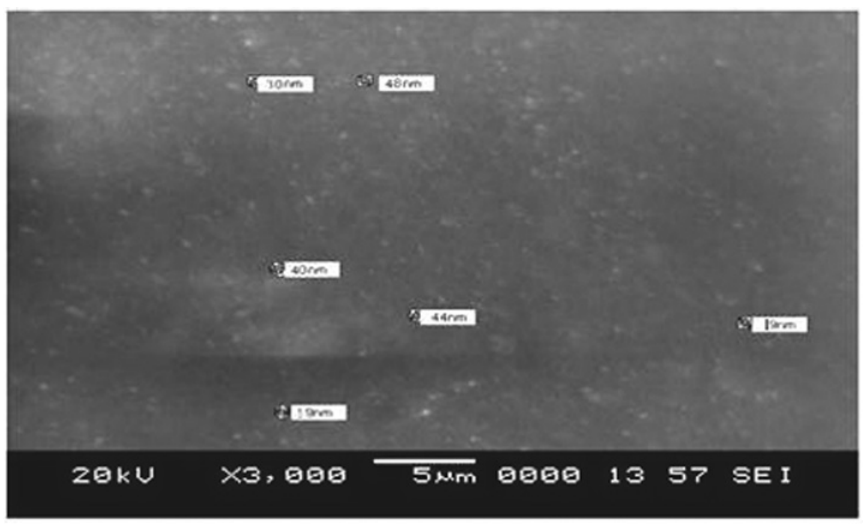
Figure 8: SEM images of PVA/( x )MWCNTs(15- x )ZnO, where x = 7.5% weight polymer nanocomposite.